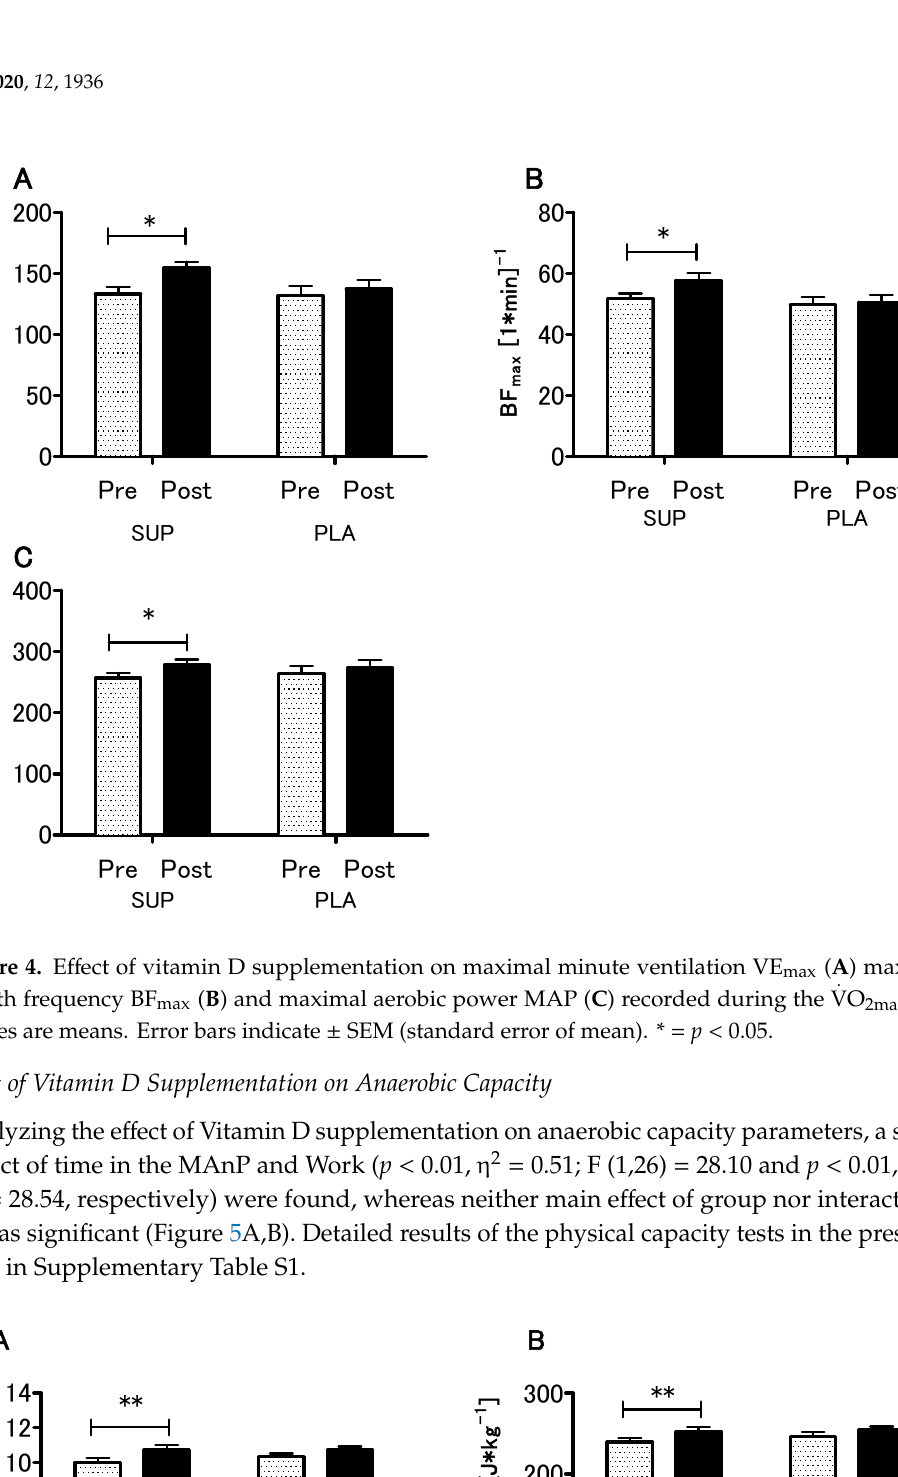
． O 2max ( A ), and contrast between SUP versus PLA